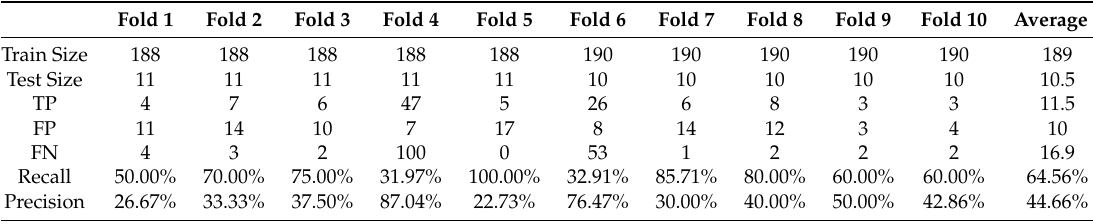
Table A10. The Results of Experiment 10: Augment the complete dataset containing images with and without dents (Dataset 6), with a larger number of